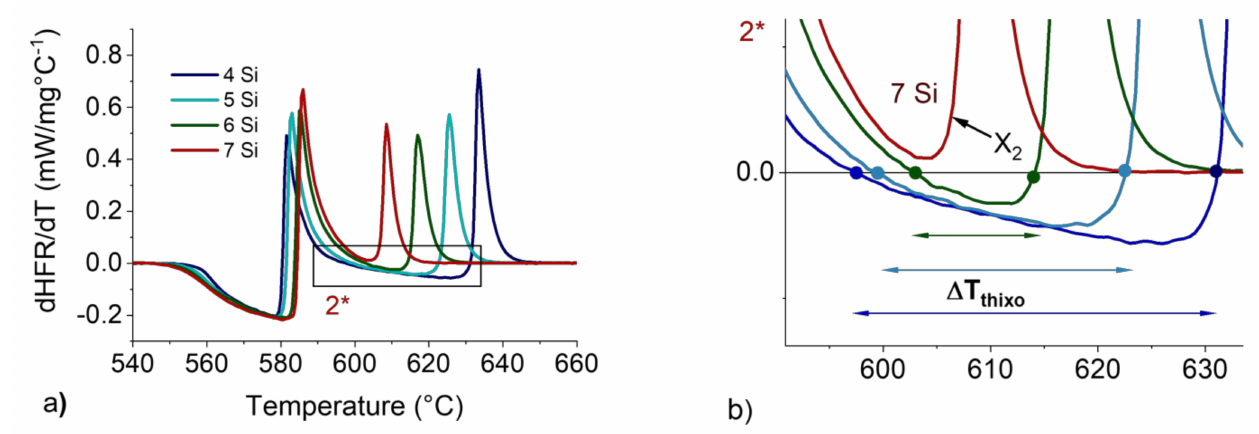
Figure 7. dHFR/dT vs. T curves for 4 to 7 wt.%Si with a 5 ◦ C/min heating rate and 200 mg sample mass ( a ). Magnification at the ∆ T THIXO zone ( b